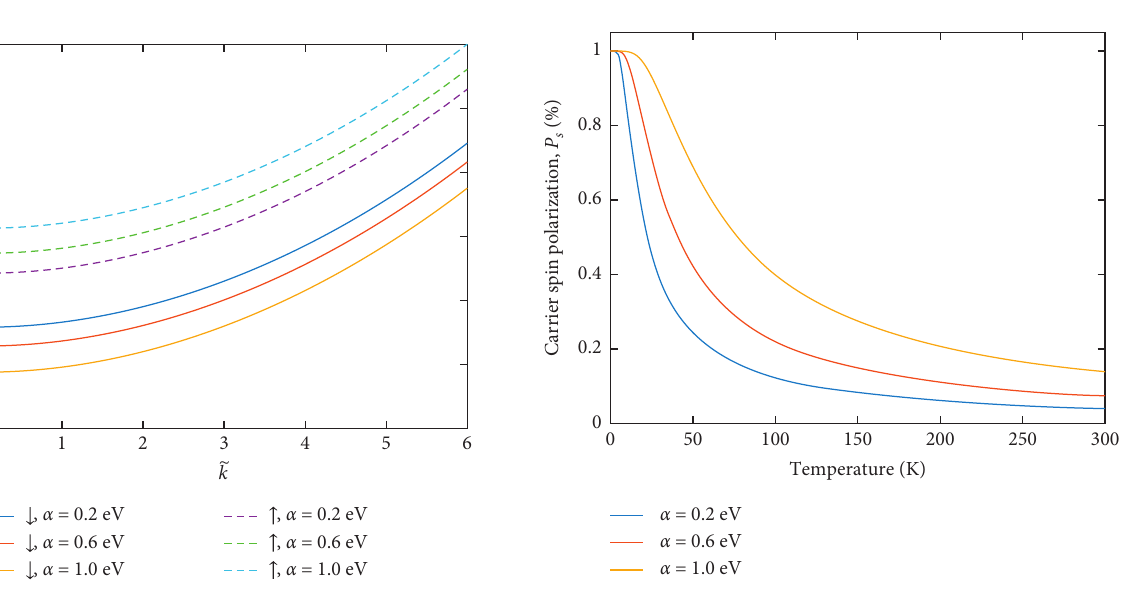
Figure 1: Carrier excitation spectrum for spin up and spin down carriers for different values of α .